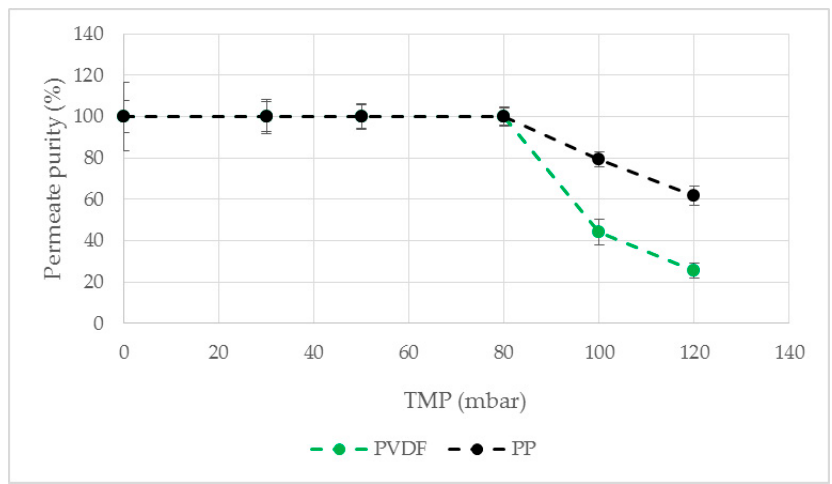
Figure 5. Permeate purity as a function of the TMP. PP and PVDF were used as membrane material for membrane modification with Tween20. ATPS4, Δ P = 30 mbar, Q = 16.7 mL/min. PP: polypropylene. PVDF: polyvinylidene fluoride.